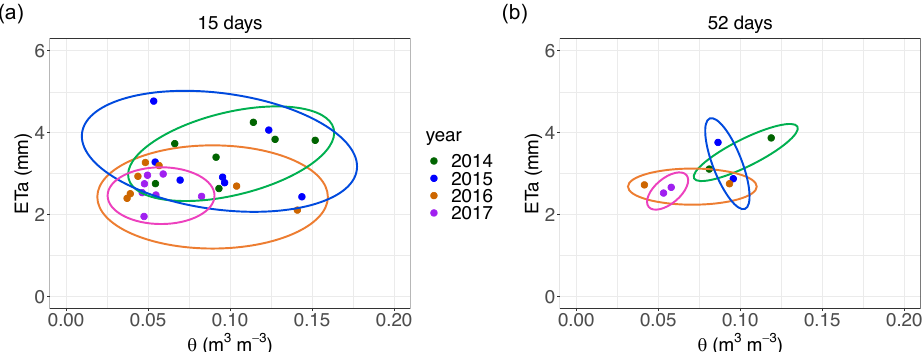
Figure A7. ( a ) Actual evapotranspiration versus average shallow soil water content (10–20 cm of depth) considering 15-days periods for each growing season. ( b ) Actual evapotranspiration versus average shallow soil water content (10–20 cm of depth) considering 52-days periods for each growing season. Ellipses highlight the different regions of the plane in which the data lay in different years. The cumulative actual evapotranspiration was normalised by the number of days of each considered time period.